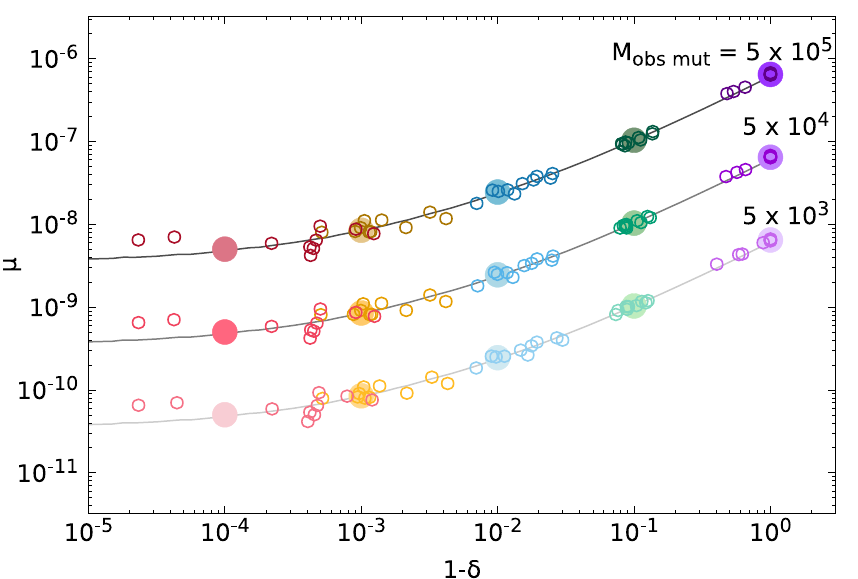
Fig 3. Joint estimates of mutation rate and death-to-birth ratio pairs. 10 synthetic dataset replicates were generated, each based on an independent cell lineage tree and associated mutations. For each true parameter pair replicates are denoted by the same color. True parameter values are indicated by large filled circles. Solid lines show the numerical approximation of parameter pairs for different values of M obs mut . Data around the middle line are the same as in Fig 2. Note that the death rate decreases along the horizontal